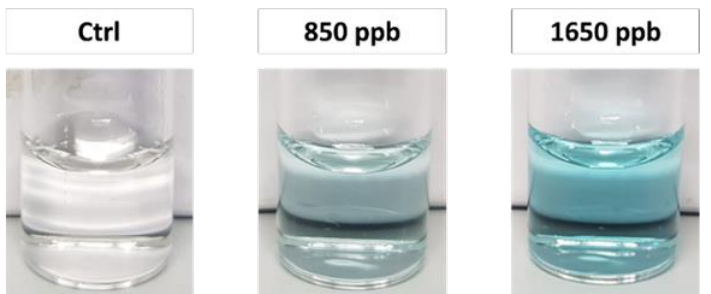
Figure 4. Color change obtained after 5 min at two different concentrations of cisplatin vs. negative control, in diluted synthetic urine (1:50).